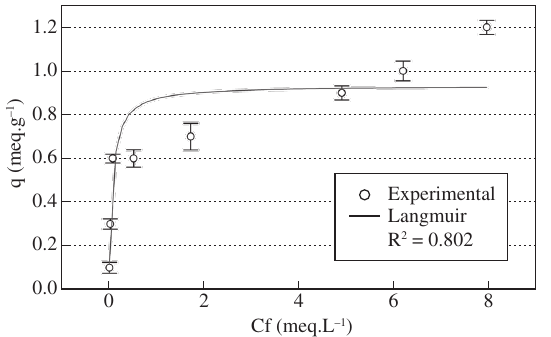
Figure 12. Equilibrium data (isotherm) of isopropilxanthate ions uptake, from aqueous solutions, by flocculated modified zeolites. Contact time: 2 hours, Cu-Z: 10 g.L –1 , temperature: 25 °C, pH: 8.0. Experimental error: ± 0.05 meq.g –1 .